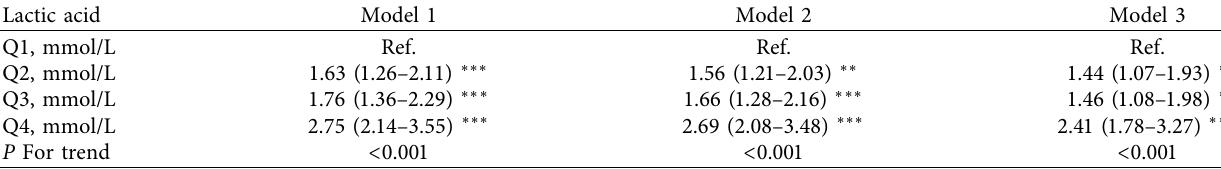
Table 2: Association between lactic acid levels and the risk of in-hospital deaths.